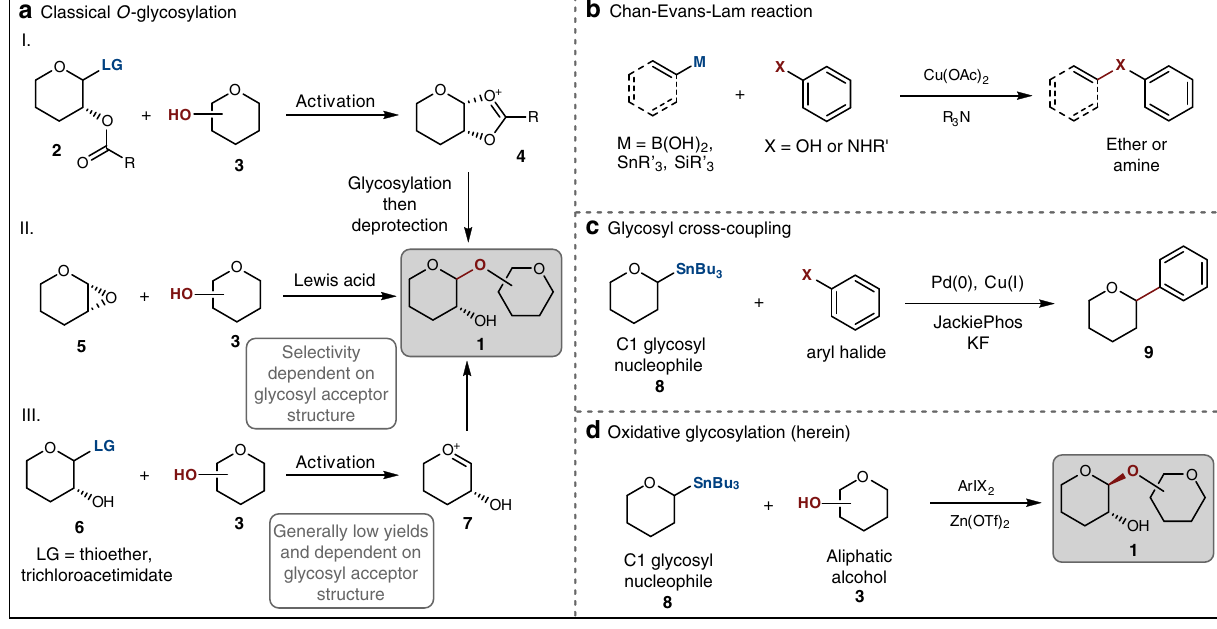
Fig. 1 Strategies for O -glycosylation and the stereochemical outcome. a (i) Neighboring group participation (2- O -acyl glycosyl donor 2 ) directed stereoselective glycosylation. Formation of dioxolenium cation 4 leads to 1,2- trans product using this method. LG leaving group (halogen, acetimidate, sul fi de, etc.). (ii) O -glycosylation via a Lewis acid-catalyzed ring opening of a glycal epoxide. The epoxide is typically prepared from the oxidation of glycal and undergoes ring opening, resulting in a 2-hydroxy 1,2- trans glycoside. (iii) O -glycosylation with glycosyl donors bearing free hydroxyl group(s). The yield of this method is diminished due to the self-conjugation, and a mixture of anomers is usually obtained. LG leaving group (halogen, acetimidate, sul fi de, etc.). b Etheri fi cation by the Chan − Evans − Lam reaction. Two nucleophiles are joined together to form an aryl ether. M main group metalloids (boronic acids, boronates, stannanes, silanes, and siloxanes). c A stereoselective C -glycosylation with a C1 nucleophile catalyzed by a transition metal catalyst. d A stereoselective O -glycosylation with glycosyl donors bearing free a hydroxyl group catalyzed by zinc tri fl